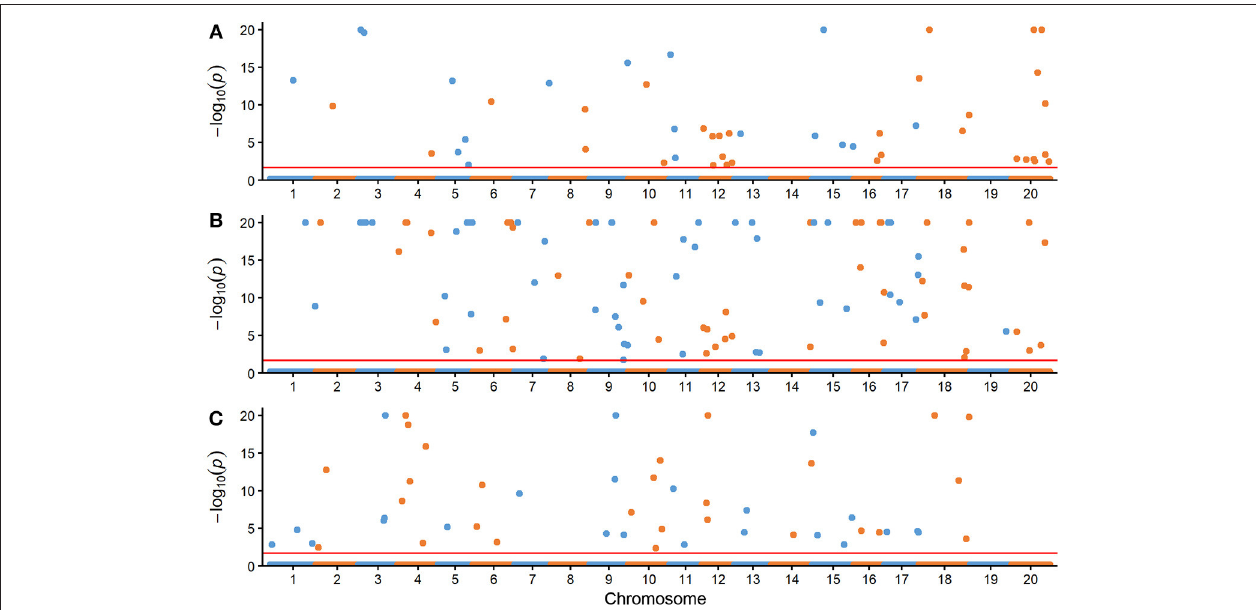
FIGURE 1 | Manhattan plots of three seed oil traits with the RTM-GWAS method. (A) Seed oil content (%), (B) oleic acid content (%) in seed oil, (C) linolenic acid content (%) in seed oil. The –log 10 ( P ) was set to 20 if it was > 20. The horizontal dotted lines represent the genome-wide threshold.